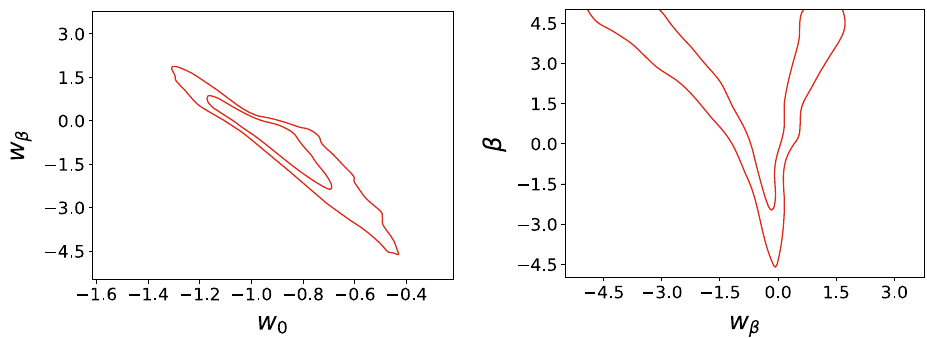
Fig. 3 The 68.3 and 95.4% confidence level contours for w 0 versus w β and w β versus β for the combined standard ruler and standard clock data. The best fit happens at w 0 = − 1 . 01, w β = 0 . 01 and β = − 0 .